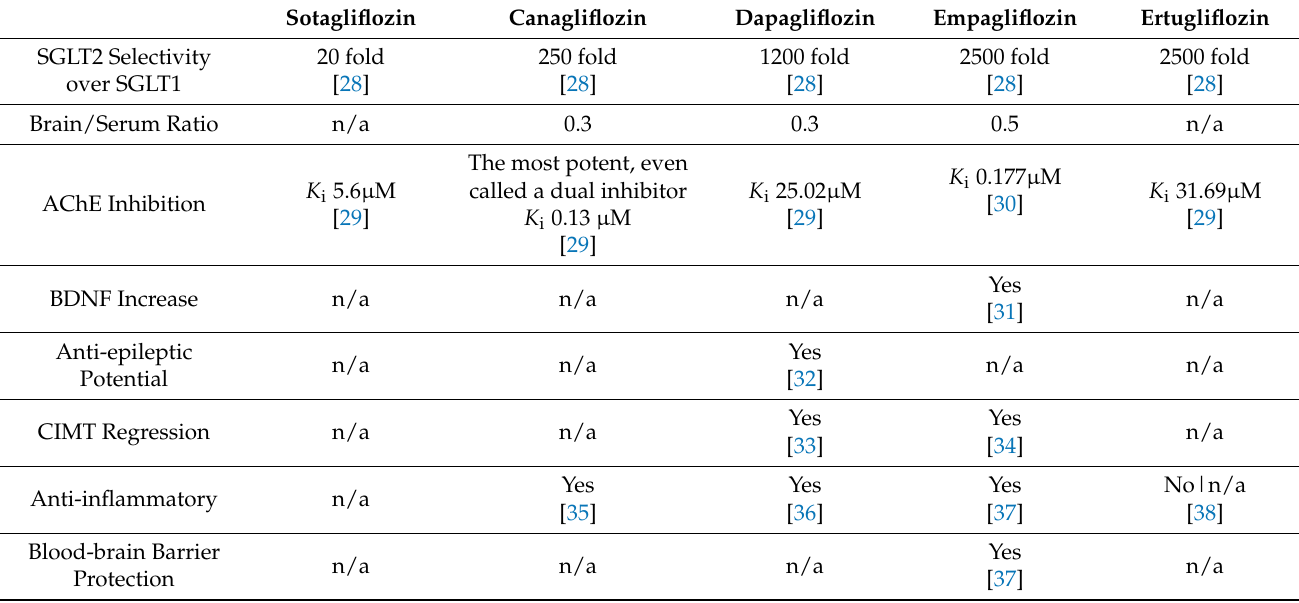
Table 1. Comparison of pleiotropic effects of Sotagliflozin, Canagliflozin, Dapagliflozin, Empagliflozin, Ertugliflozin.